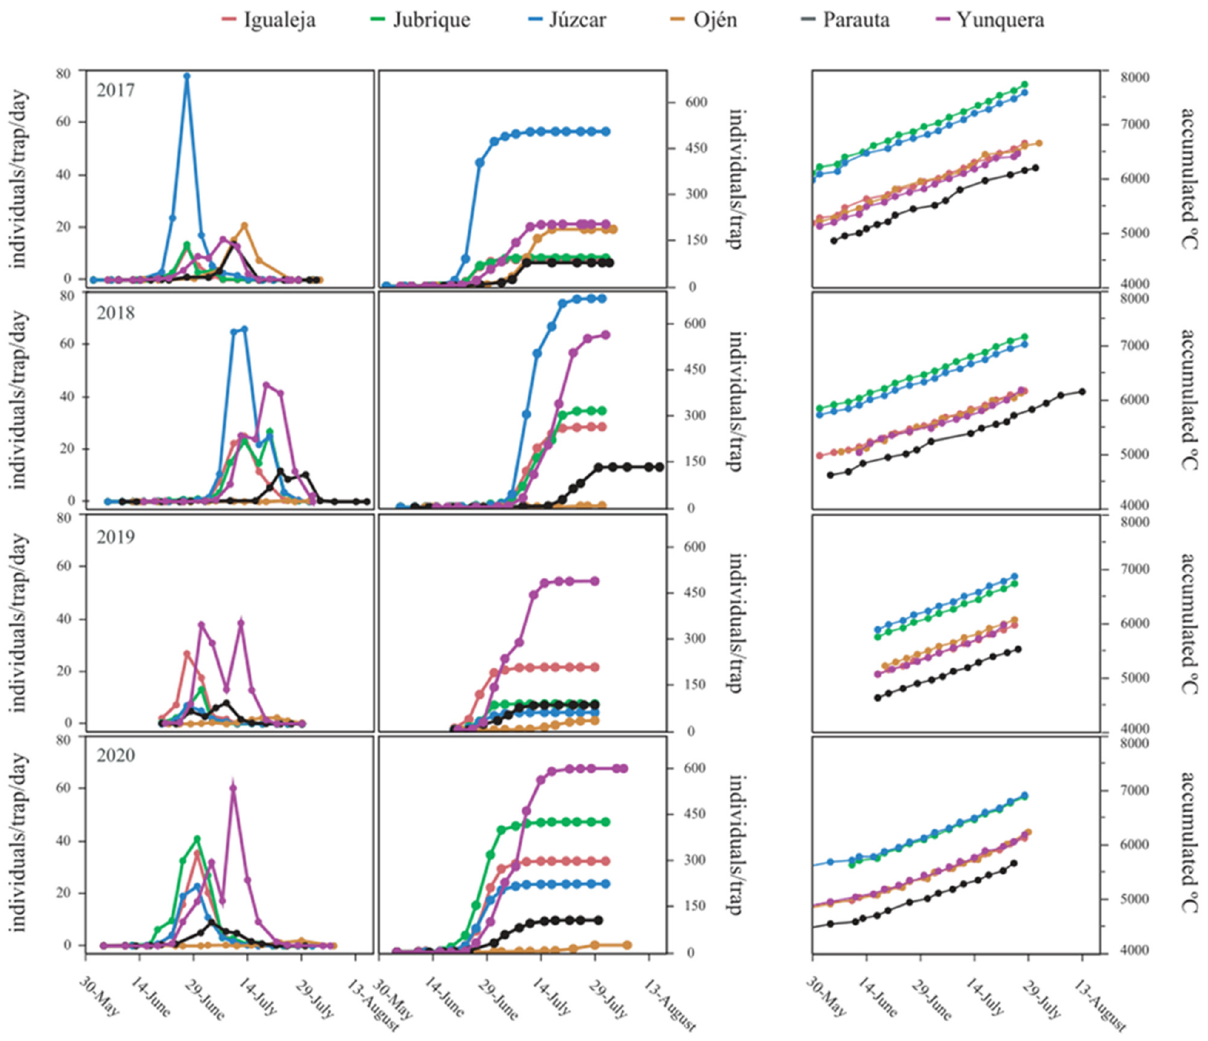
Figure 4. Variation in the flight period of CGW over years in the sampled localities of Málaga. On the left, line chart of year x locality effects on the number of CGW individuals per trap and day. In the middle, cumulative number of CGW individuals per trap and season. On the right, cumulative °C per sampling date, locality and season. See the effect of locality × year in the clustered heatmap for CGW flight start date, flight peak date and flight end date in Figure S2.